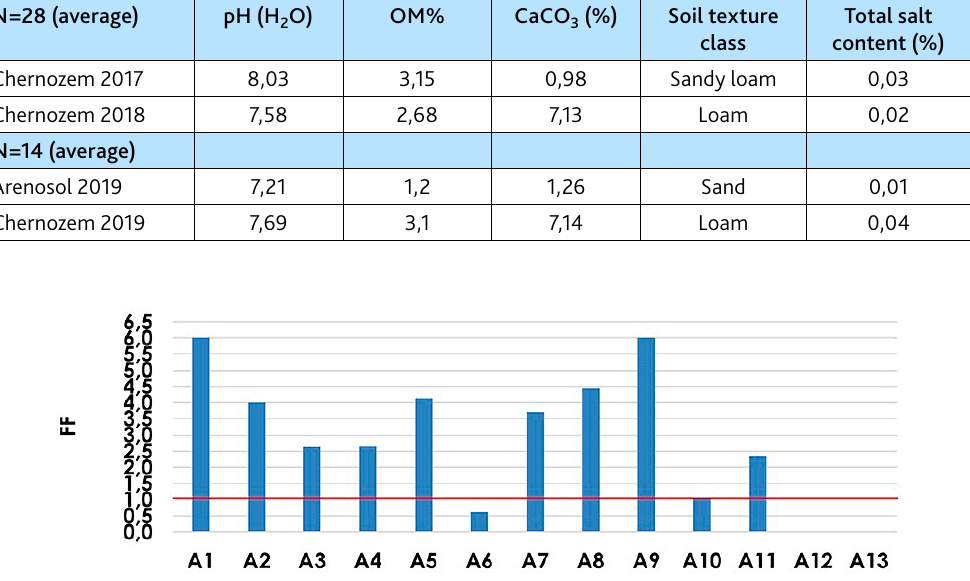
Figure 7. Chlorpyrifos enrichment ratios (ER) in the rolled sediment (A1-A11: Chlorpyrifos-treated area, A12-A13: control